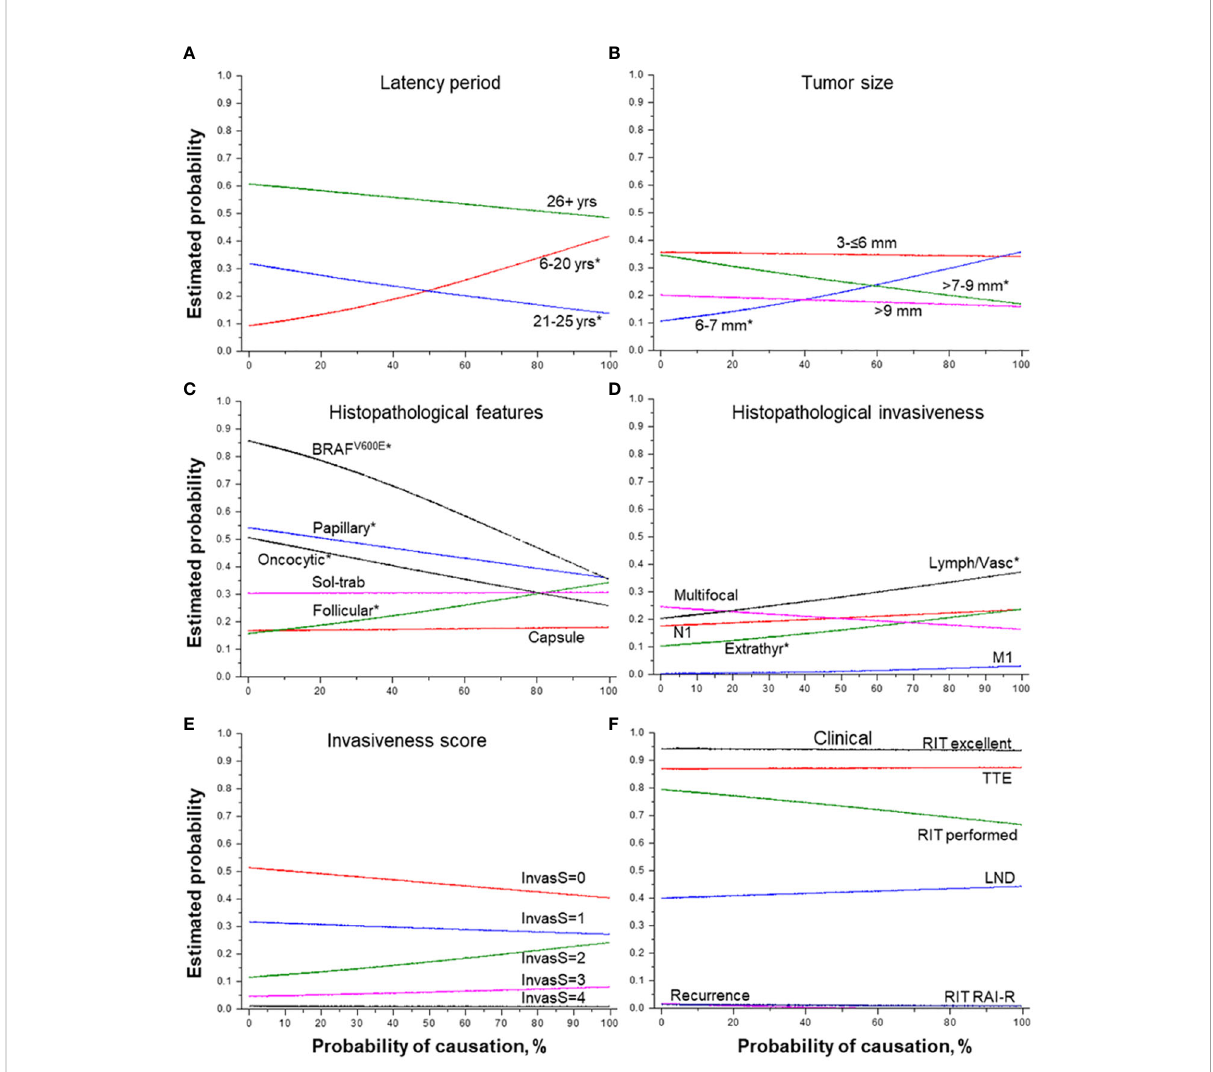
FIGURE 3 Effect of the probability of causation of a tumor due to radiation on MPTC characteristics. (A) latency period (by groups), (B) tumor size (by groups), (C) histopathological features, (D) histopathological features of tumor invasiveness, (E) the integrative invasiveness score, and (F) clinical parameters. RIT, radioiodine therapy; TTE, total thyroidectomy; LND, lymph node dissection; RAI-R, radioiodine-refractory. * indicate statistical signi fi cance, p <